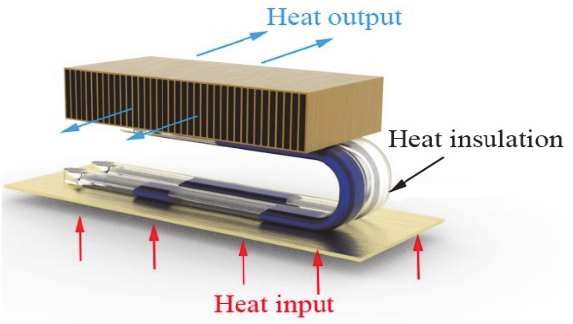
Figure 10. Computational domain with boundary conditions. Table 4. The details of the copper matrix.